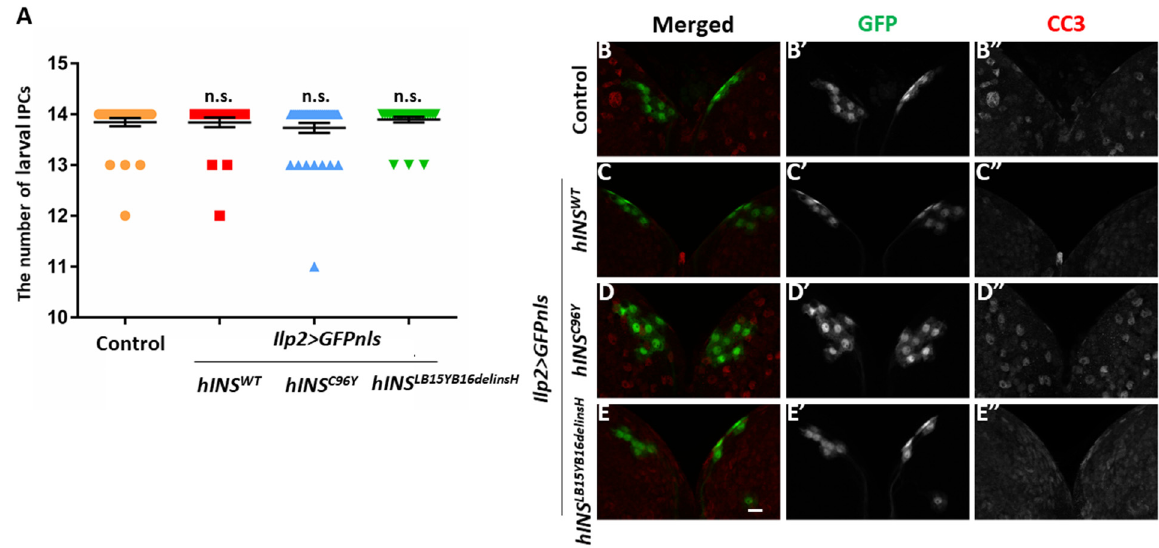
Figure 5. The ectopic expression of neither of hINS C96Y or hINS LB15YB16delinsH induced caspase activation or the loss of larval IPCs. ( A ) The number of larval IPCs in control larvae and larvae expressing human preproinsulin at the third-instar stage. Note that the differences in the IPC number between larvae expressing every three types of preproinsulin and control larvae ( ilp2 > GFPnls ) were not significant ( n > 25, n.s.: not significant, Mann–Whitney’s U -test). ( B – E ) Immunostaining of third-instar larval brains having IPCs labeled with GFPnls with anti-Cleaved Caspase-3 (CC3) antibody. Red in B–E (white in ( B ”– E ”)): Anti-CC3 immunostaining signal. Green I n ( B – E ) (white in ( B ’– E ’)): IPCs visualized by expression of GFPnls.